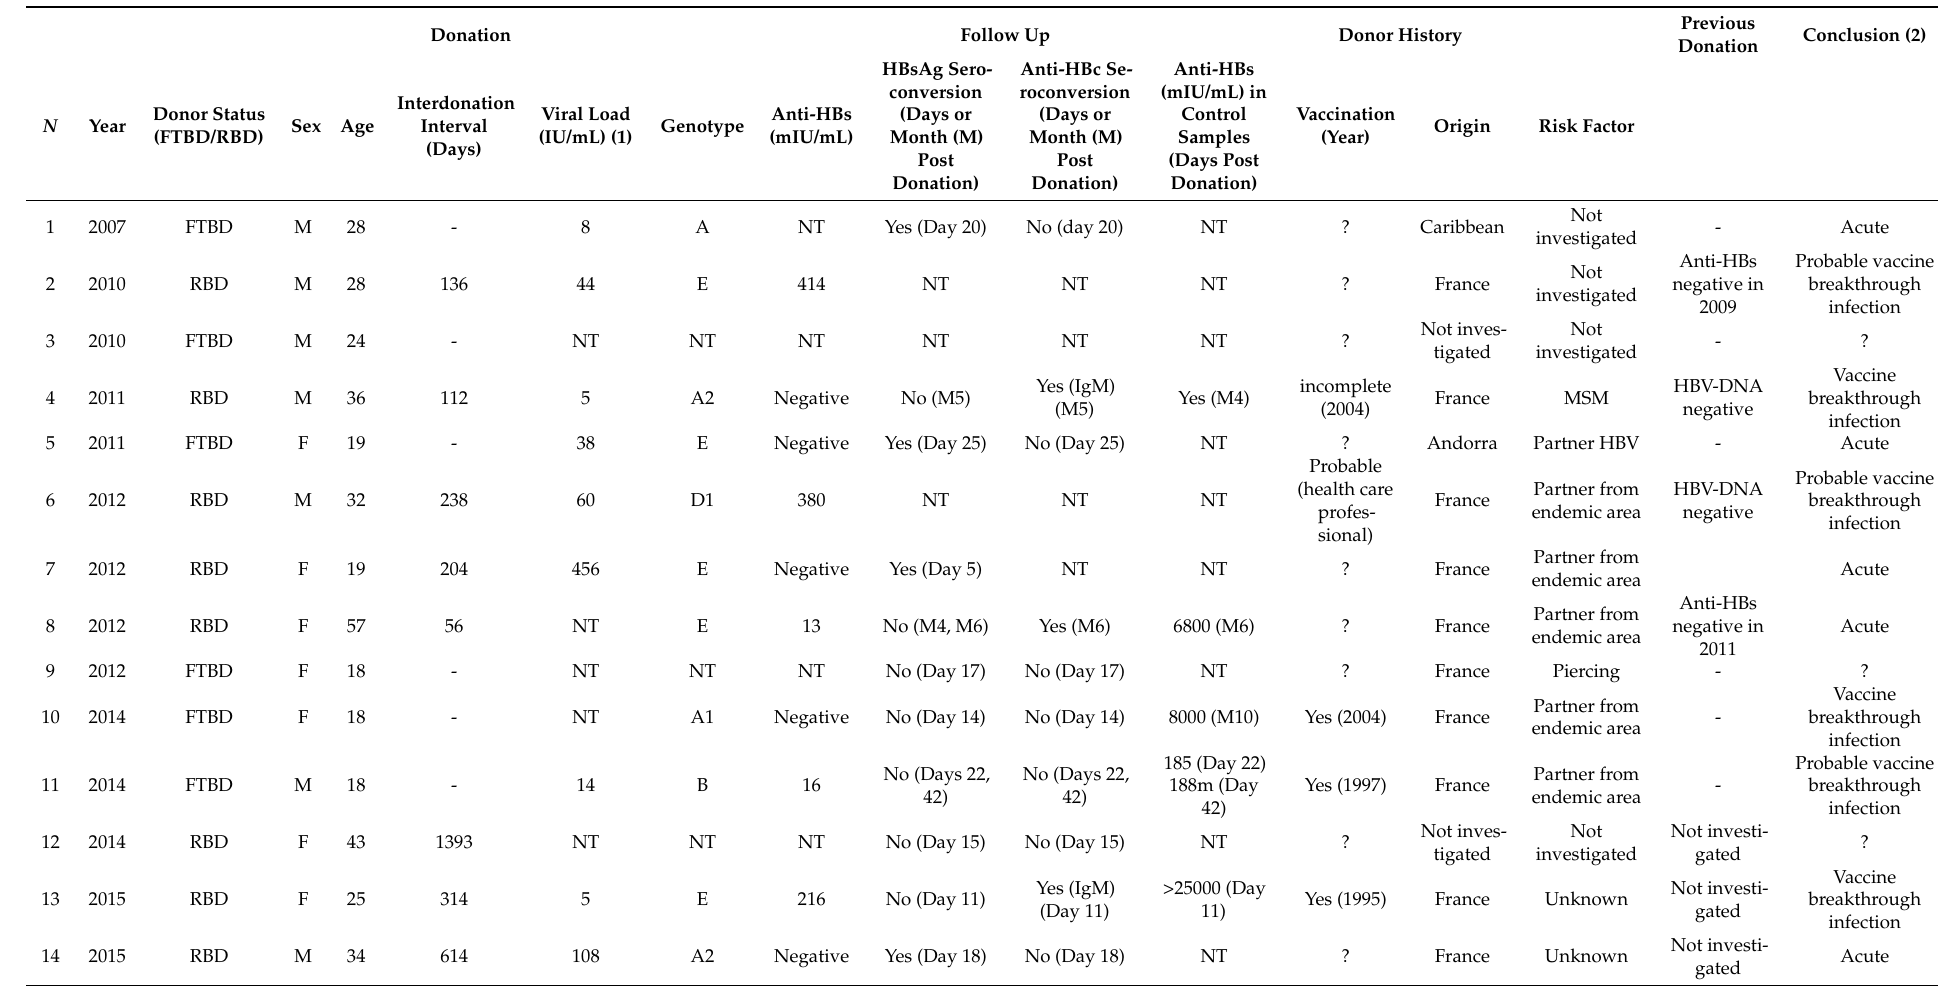
Table 2. Characteristics of the HBV-DNA positive/HBsAg negative/anti-HBc negative infections in blood donors in France from 2005 to